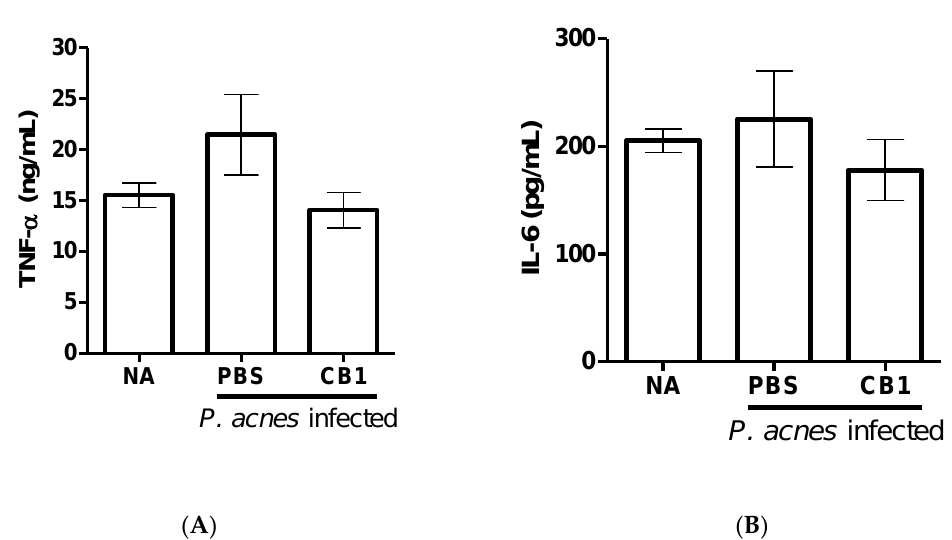
Figure 4. Anti-inflammatory effect of compound 19 in P. acnes ear infection model. ( A ) TNF-α, ( B ) IL-6. The data were pooled from two independent experiments. Error bar indicated the standard deviation of the mean (SEM). Control: naïve mice (N = 2); PBS: P. acnes infected, PBS-treated mice (N = 6); CB1: P. acnes infected, 19 (20 mg/kg)-treated mice (N = 7). p -value between PBS and CB1 for TNF-α and IL-6 were 0.098 and 0.377, respectively.